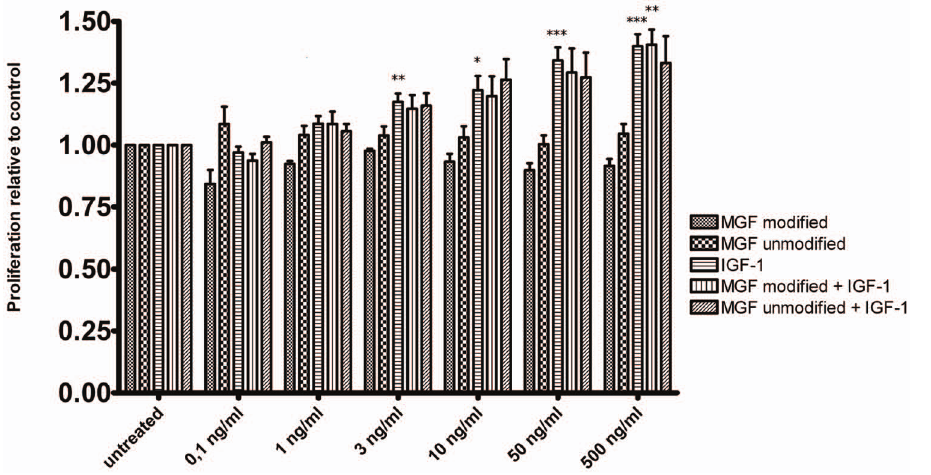
Figure 7. Proliferation effects of MGF/IGF-1. Effects of IGF-1, different MGF peptides and their combination on proliferation of porcine growth plate chondrocytes as measured by BrdU staining. (n=5–11 per group; One-way ANOVA of log-transformed data, Games-Howell post-hoc analyses: * p , 0.05; ** p , 0.01; *** p , 0.001 vs respective untreated control; Data are shown as mean + SEM).